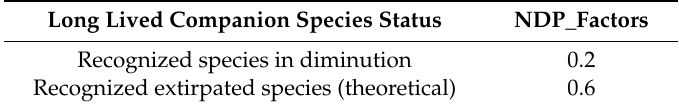
Table 3. Naturalness degradation potentials (NDPs) for long lived companion species.